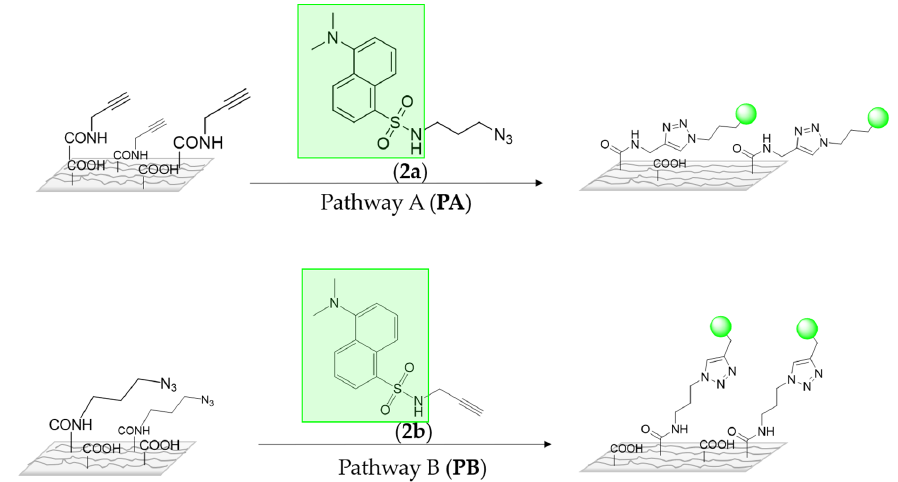
Scheme 3. A schematic representation of two ways to immobilize the fluorophore derivative.